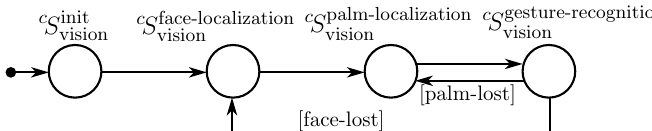
Figure 11. The FSM switching behaviours of the control subsystem c brackets contain initial